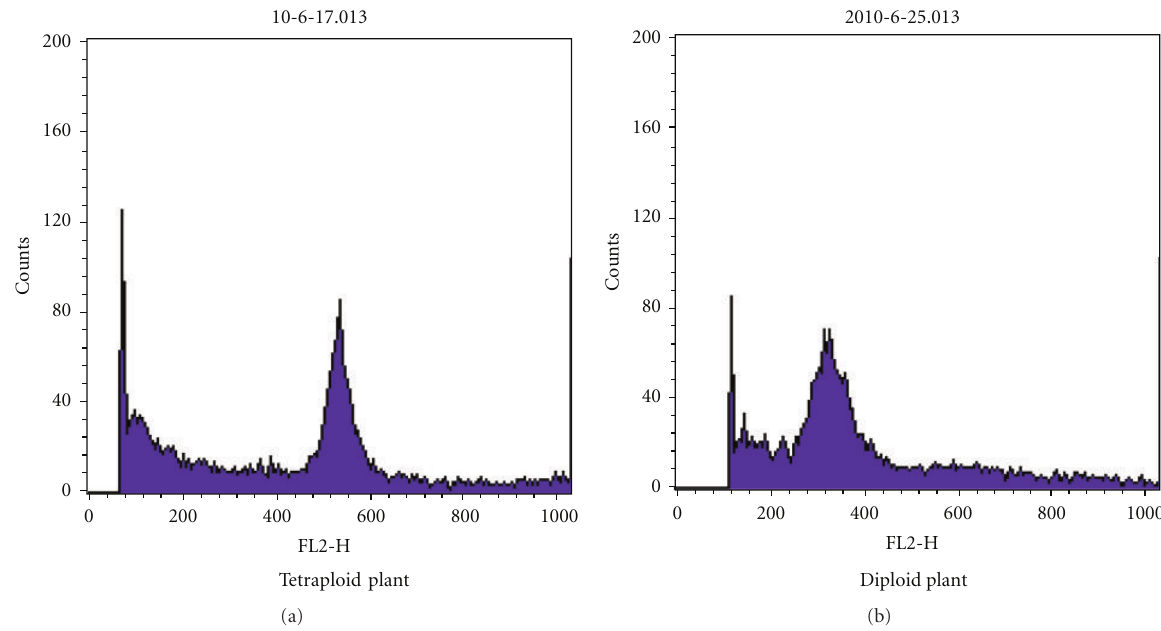
Figure 2: Histogram of the relative fluorescence intensity of nuclei isolated from the leaves of diploid and tetraploid C. roseus plant. (a) The control diploid plant of C. roseus and (b) a tetraploid plant of C. roseus .